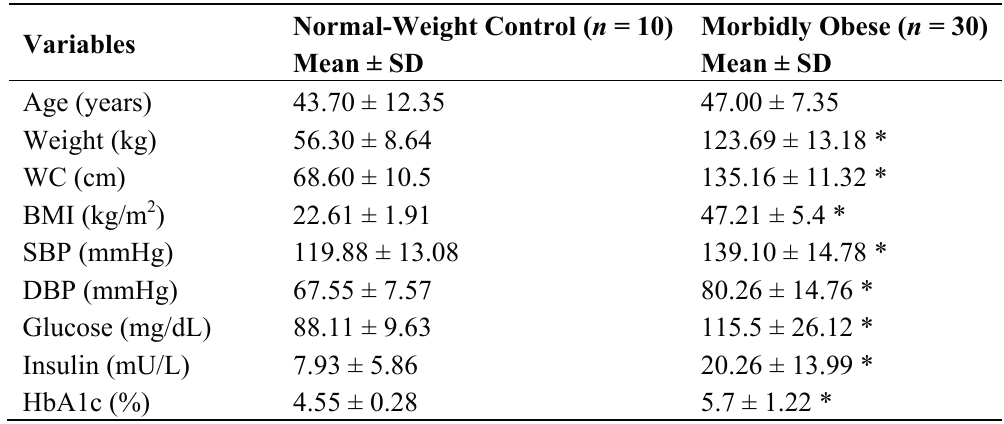
Table 1. General baseline characteristics and metabolic variables of the cohort studied: normal-weight control women and morbidly obese